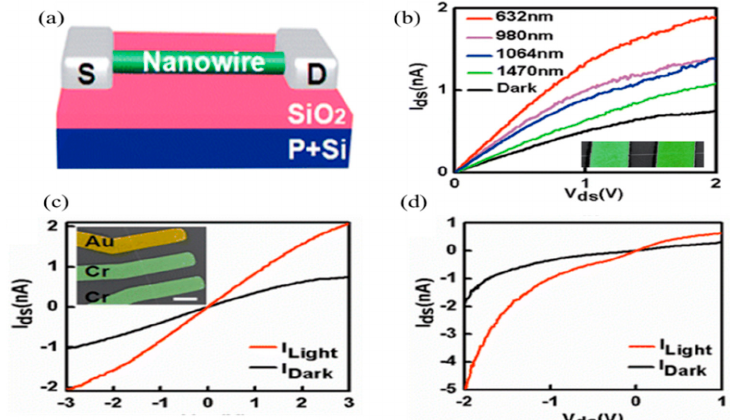
Figure 5. ( a ) Schematic illustration of an InAs NW-based photodetector; ( b ) photocurrent spectra of an InAs NW near-infrared photodetector changing from red to NIR light and the inset is the SEM image of a representative photodetector; ( c ) the dark and photocurrent at ohmic–ohmic combinations in the detectors and the inset shows Au/Cr contact as electrodes; ( d ) the photo-response at the Schottky–Ohmic contact combination (reproduced with the permission of Reference [37], Copyright 2014, American Chemical Society).